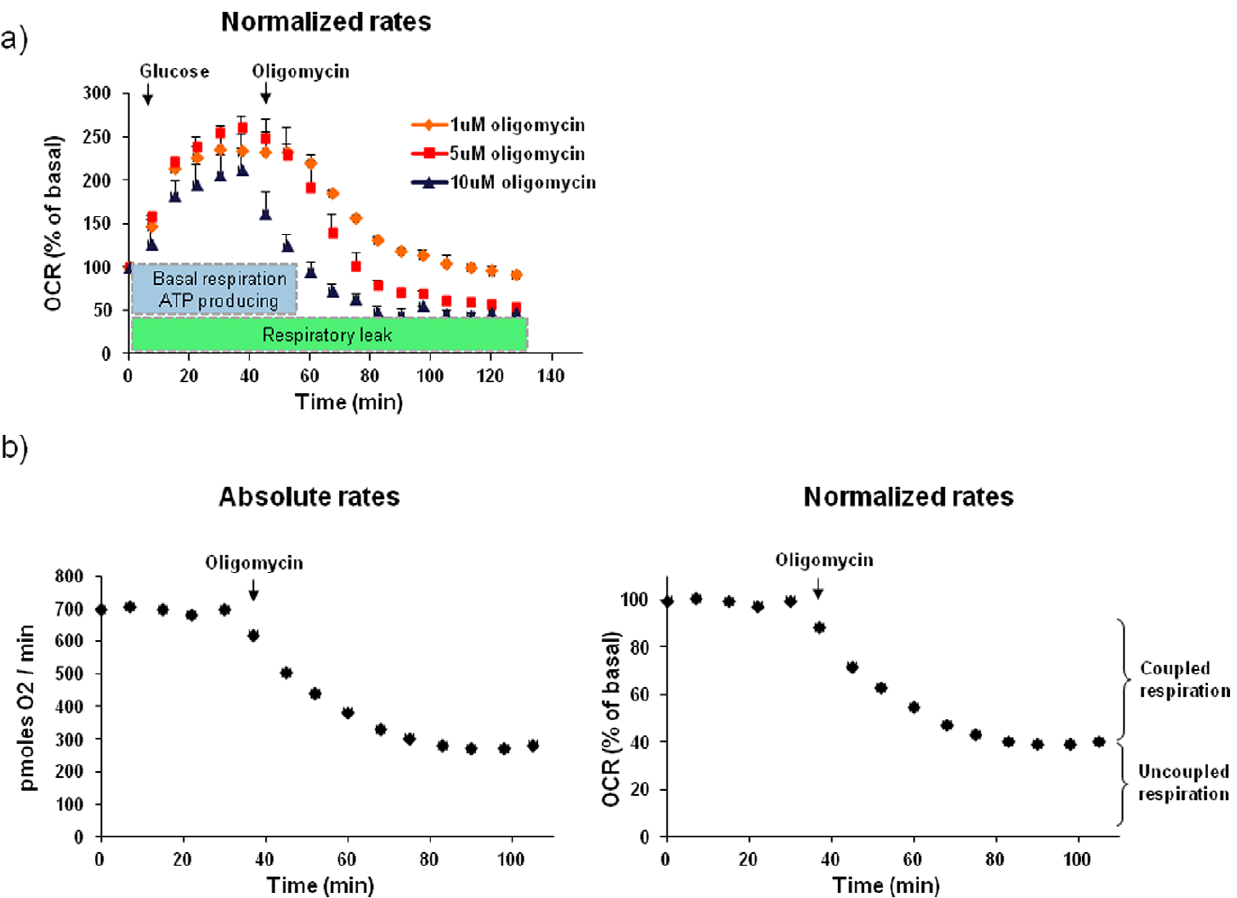
Figure 2. Measuring coupling efficacy. A) Oligomycin titration. The F1F0 ATP synthase inhibitor oligomycin was added after 20 mM glucose as indicated. Note that 5 m M oligomycin has a similar effect as 10 m M. B) Experimental setup to measure uncoupling. A few data points are recorded under basal conditions (3 mM glucose) followed by injection of oligomycin. The remaining OCR under oligomycin represents respiration that is not coupled to ATP synthesis (uncoupling). Data is shown both as absolute rates (left) and normalized to initial values (right). C) FCCP increase OCR under oligomycin. To verify the capacity of oligomycin to reveal uncoupling, islets were treated with FCCP (1 m M) prior to oligomycin. Note the increase in OCR under oligomycin representing maximal uncoupled respiration. D) Norepinephrine activated brown adipocytes show higher respiration under oligomycin. Basal measurement was followed by injection of control media or media containing 1 m M norepinephrine which activates uncoupling. Note the increase in OCR under oligomycin indicative of uncoupling. E) Oligomycin does not alter non-mitochondrial respiration. OCR was first measured with no drugs present followed by injection of only oligomycin (OM) or both oligomycin and rotenone/myxothiazol (Rot) (5 m M of both). Later, islets that were only injected with oligomycin at first also received rotenone/myxothiazol. Note that there is no difference in non mitochondrial respiration (under rotenone/myxothiazol) between the different treatments indicating that oligomycin does not alter non mitochondrial respiration.